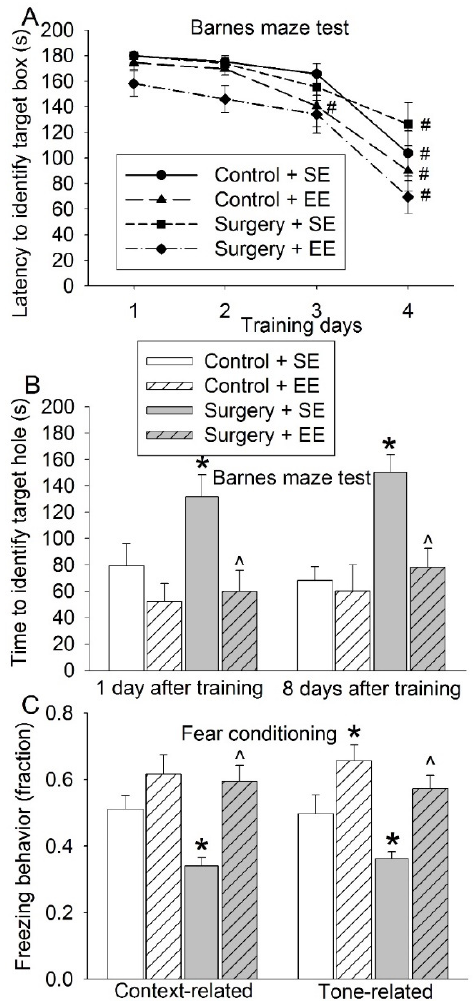
Figure 2. Effects of environmental enrichment and surgery on learning and memory. Eighteen-month-old mice were subjected to right carotid artery exposure and environmental enrichment. They were starting to be tested by the Barnes maze and fear conditioning 2 weeks after surgery. ( A ) Performance during the training sessions of the Barnes maze test. ( B ) Performance during the memory phase of the Barnes maze test. ( C ) Performance in the fear-conditioning test. Results are means ± S.E.M. ( n = 10). # p < 0.05 compared with the corresponding data on day 1, * p < 0.05 compared with control, ^ p < 0.05 compared with surgery group.